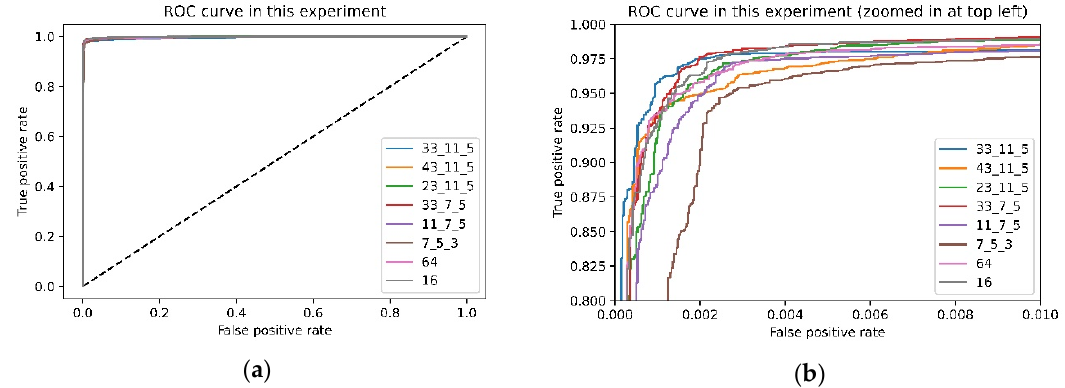
Figure 5. Receiver operating characteristic (ROC) curve about this experiment: ( a ) original ROC curve; ( b ) zoomed ROC curve.